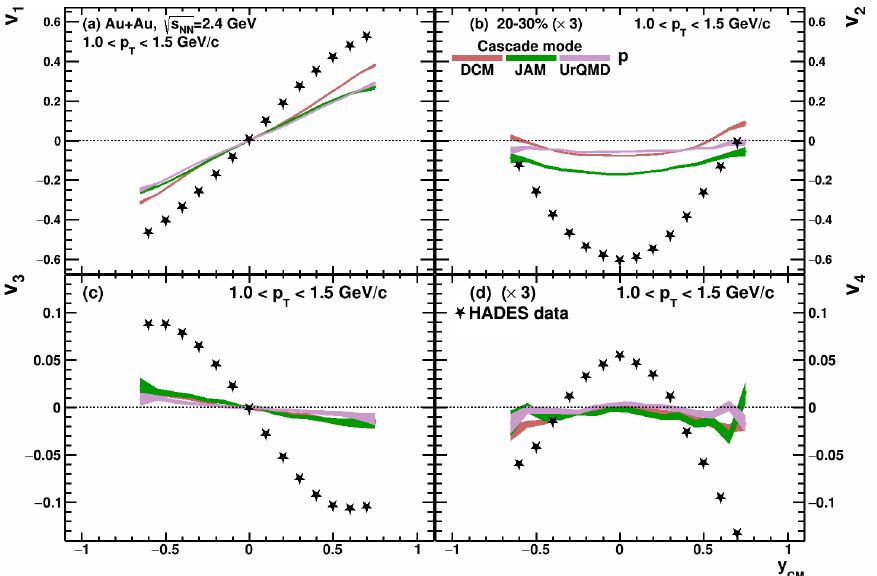
Figure 5. Rapidity ( y cm ) dependence of anisotropic flow coefficients v 1 , v 2 , v 3 and v 4 of protons ( a – d ) √ s NN = 2.4 GeV. The black-closed symbols denote the in the 20–30% central Au + Au collisions at published data from the HADES experiment [17]. The red, green and purple bands represent the results from the cascade mode of DCM-QGSM-SMM, JAM, and UrQMD models, respectively. The uncertainties of the simulated model data are statistical.